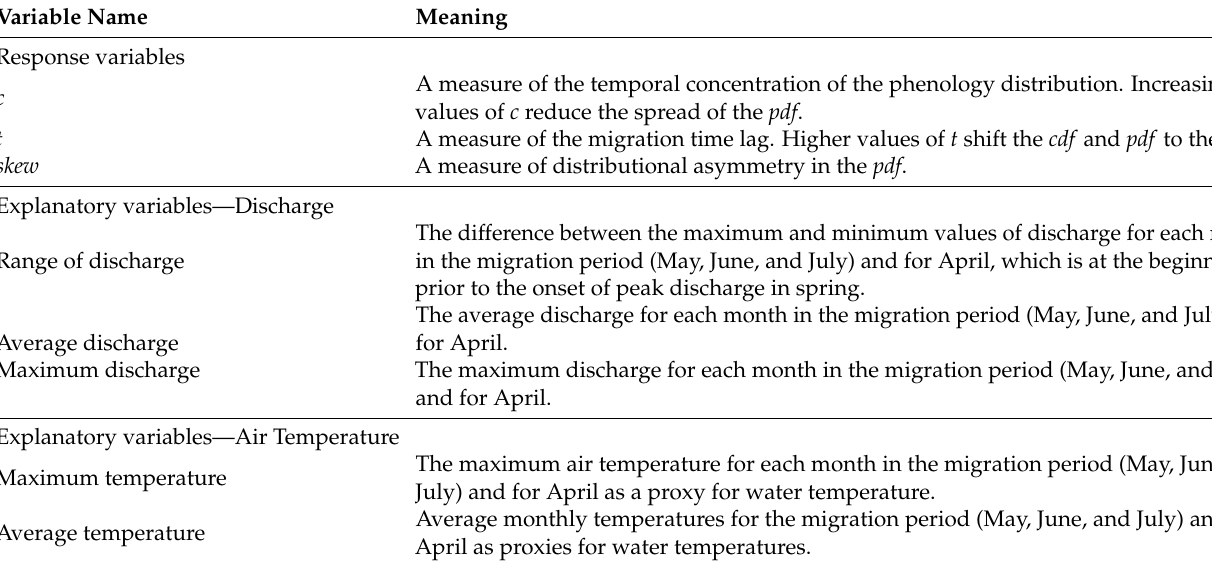
Table 1. Response and explanatory variables included in correlation analysis of migration phenologies of juvenile Chinook, chum, and coho salmon from the Yukon River, 2014–2019 and 2021. pdf = probability density function, cdf = cumulative distribution